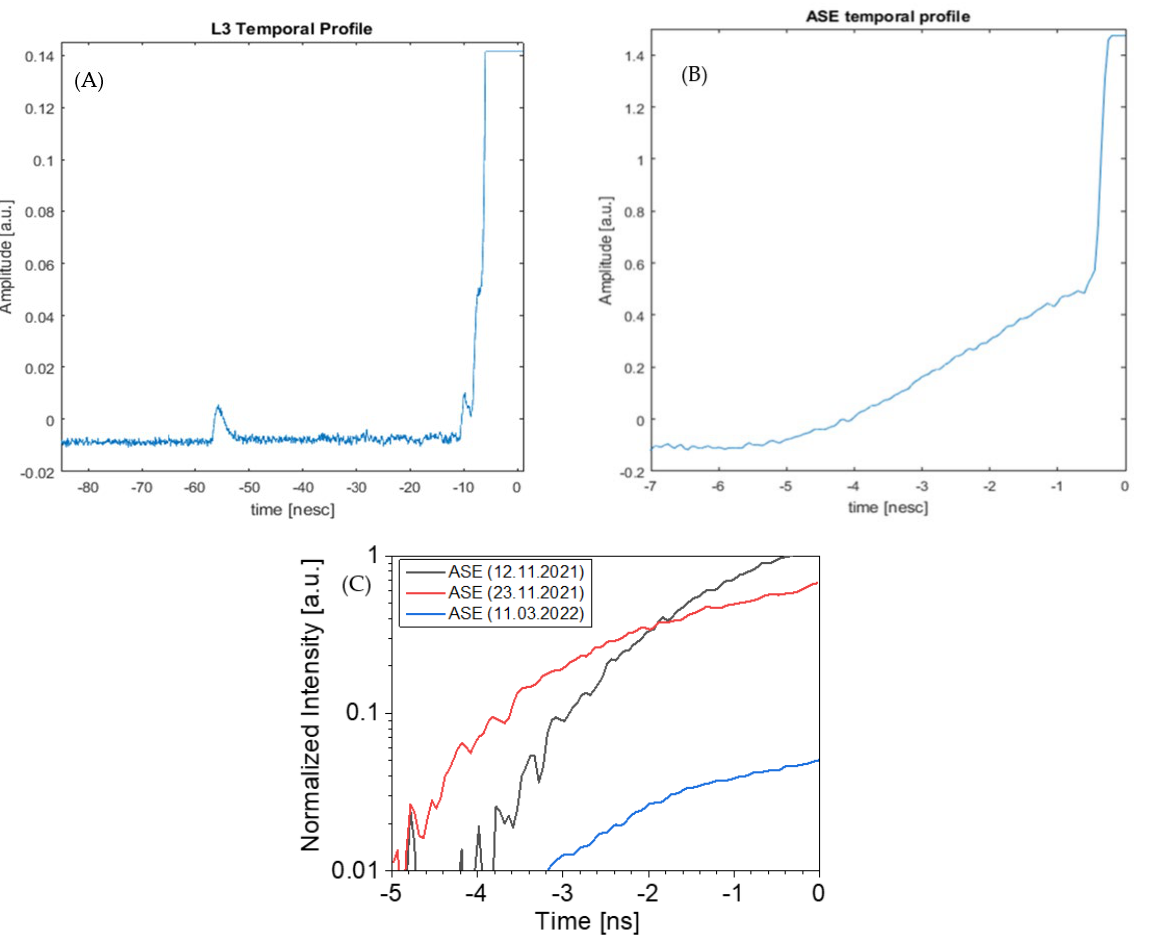
Figure 12. L3 temporal profile measured at the ELIMAIA BDS for ( A ) pre-pulse analysis in the long time scale and ( B ) short time scale for intensity contrast estimation with respect to the main ultra-intense pulse. ASE reduction plot, associ- ated to an increase of the L3 contrast ( C